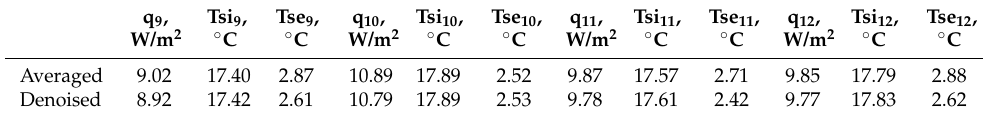
Table 5. Results of conductive thermal resistance calculations.